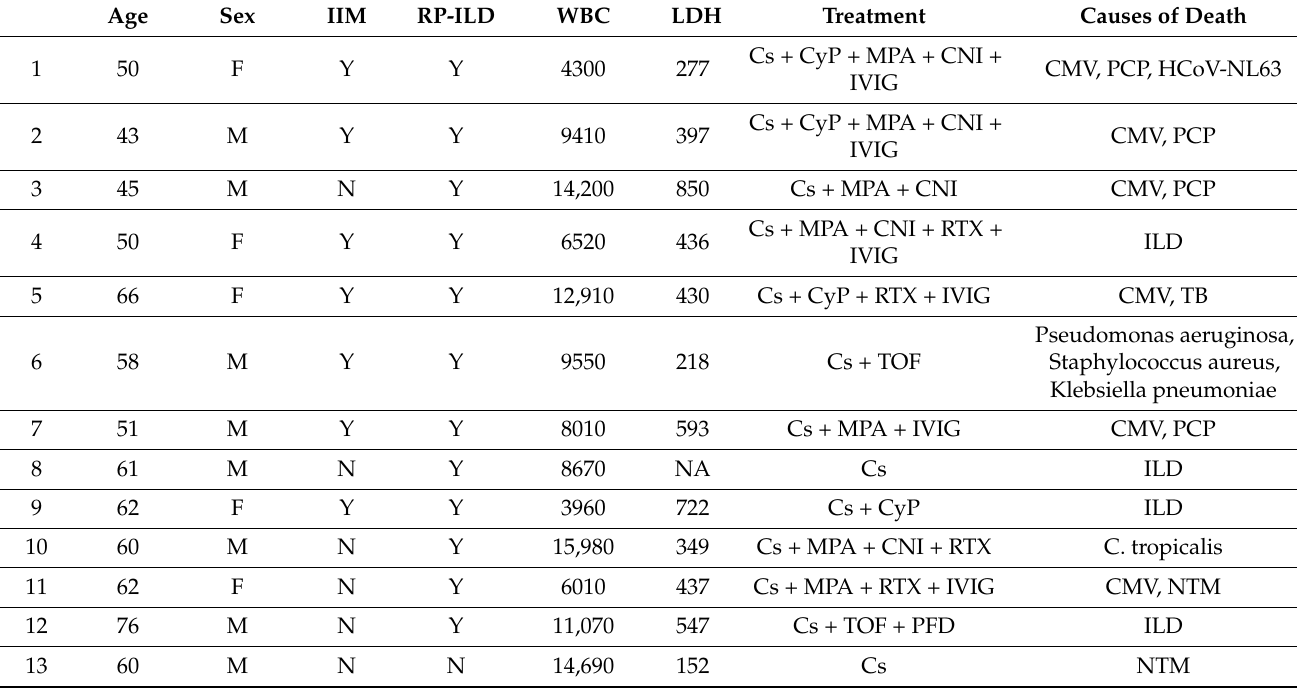
Table 2. Treatment and causes of death in